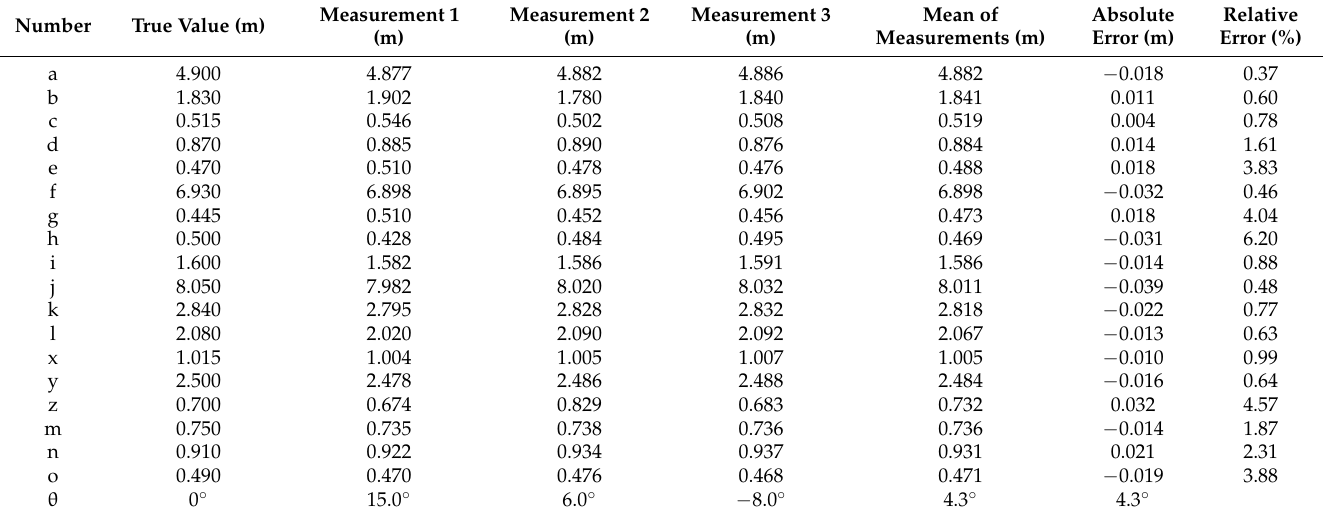
Table 5. Plugin description in